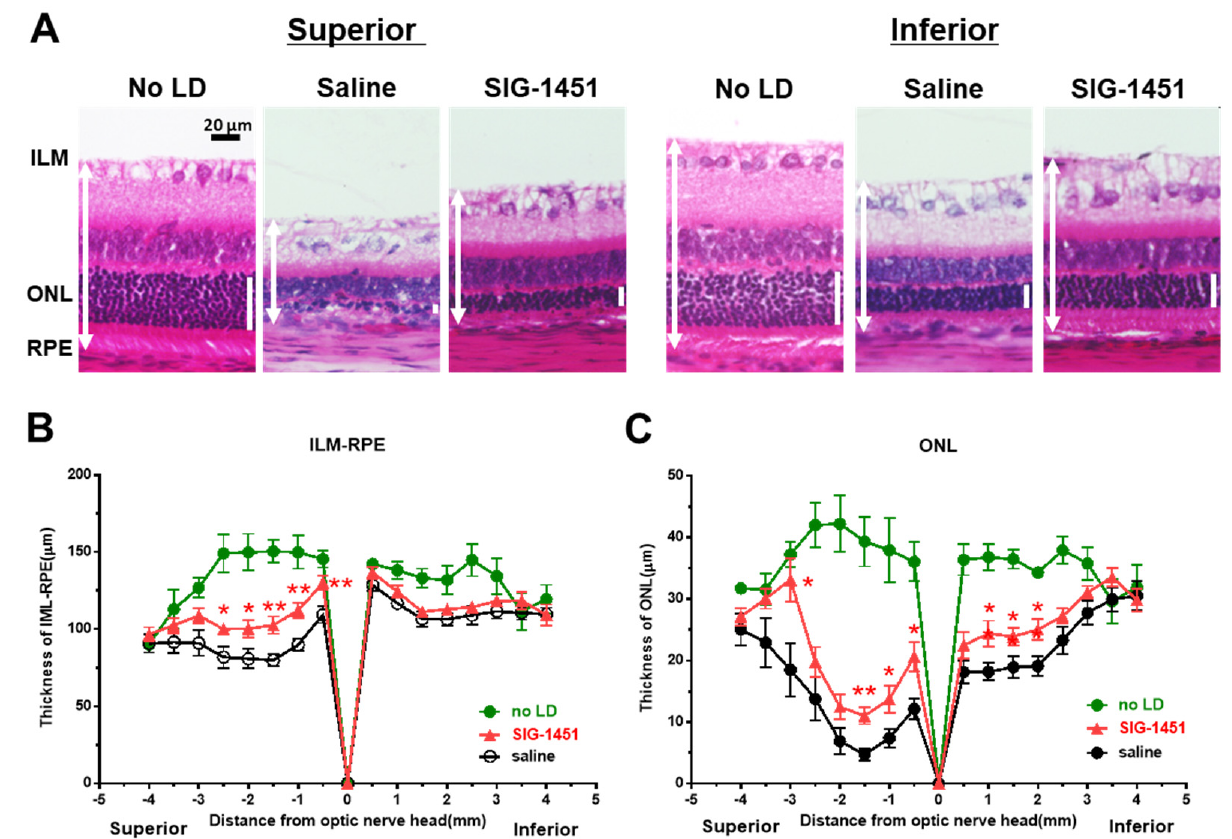
Figure 2. Histological examination of retinas 8 d after light damage. Typical microphotographs of the superior and inferior parts of the retina ( A ). ILM-RPE ( B ) and ONL ( C ) thicknesses in saline- and SIG − 1451-treated rats. Data are represented in terms of the mean ± SE values (saline: n = 14, SIG − 1451: n = 16, unpaired t -test; *, ** p < 0.05, 0.01).